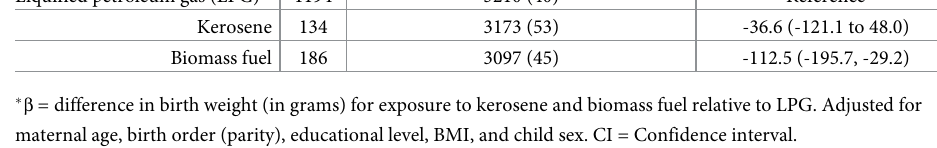
Table 2. Association between cooking fuels and birth weight (in grams) among term births, result of linear regres- sion from CEGROMS (N = 1514). Predictor N Least square mean birth weight, g (SE) β (95% confidence Interval) Liquified petroleum gas (LPG) 1194 3210 (40) Reference